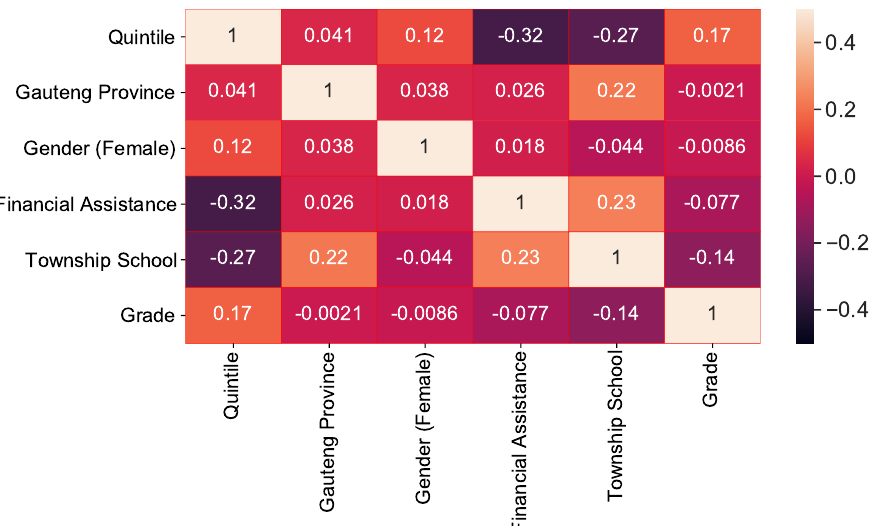
Figure 2. Pearson Correlation Coefficients of the Chosen Features. Quintile and Township School had the highest correlation with Grade.